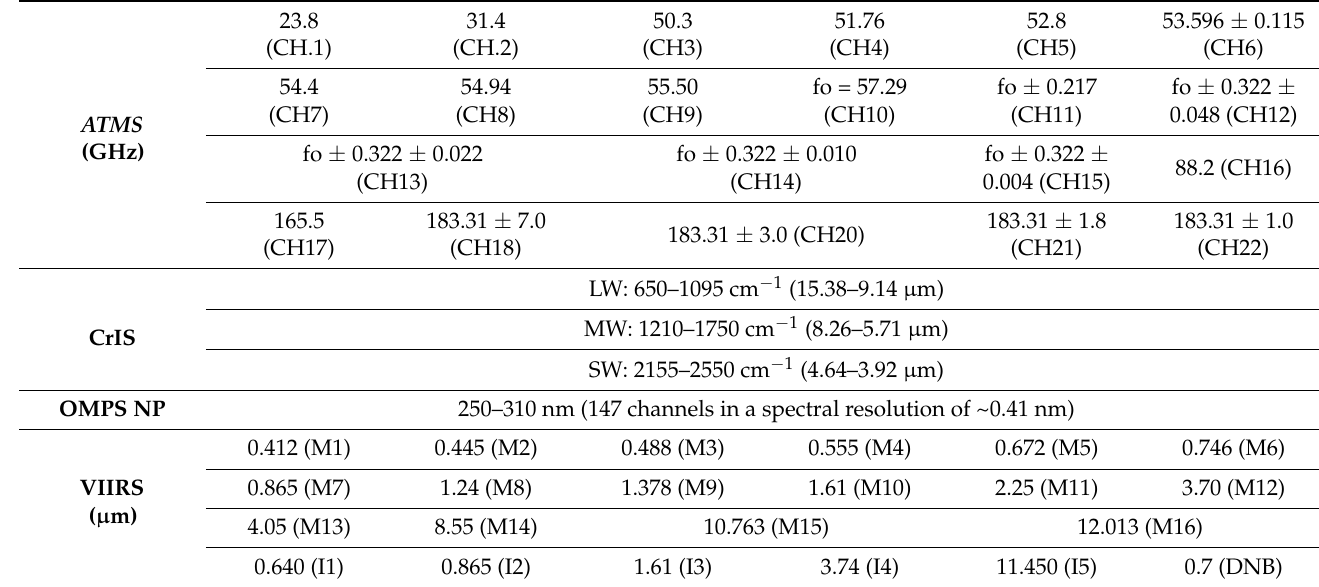
Table 1. Channel or band information of ATMS , CrIS, OMPS NP, and VIIRS